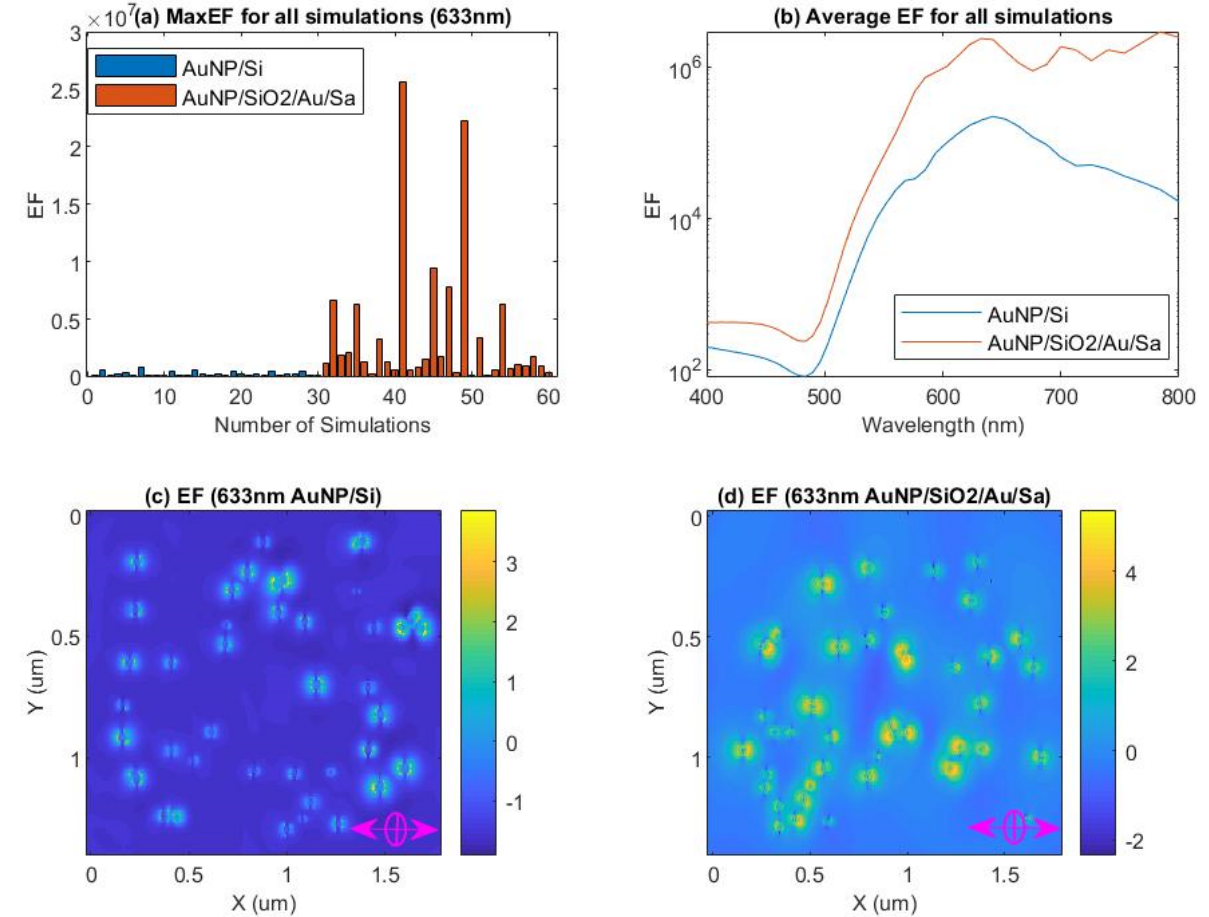
Figure 6. FDTD simulation of randomly distributed gold nanoparticles on silicon substrate (AuNP/Si) and randomly distributed gold nanoparticles on a silicon dioxide interception layer over a gold mirror on sapphire substrate (AuNP/SiO 2 /Au/Sapphire). ( a ) Maximum enhancement factor ( \ E \ / \ E 0 \ ) 4 at incident wavelength 633 nm for each run of model AuNP/Si and model AuNP/SiO 2 /Au/sapphire over an amount of 30 simulations, respectively. ( b ) Average value of the maximum enhancement factor ( \ E \ / \ E 0 \ ) 4 depends on the incident wavelength over an amount of 30 sim- ulations for model AuNP/Si and model AuNP/SiO 2 /Au/Sapphire, respectively. ( c ) Randomly selected enhancement factor ( \ E \ / \ E 0 \ ) 4 at the foot of randomly distributed gold nanoparticles on the surface of a silicon substrate (at XY plane) for model AuNP/Si with an incident wavelength of 633 nm. The color bar of the enhancement factor was in log scale (log{ ( \ E \ / \ E 0 \ ) 4 }). ( d ) Randomly selected enhancement factor ( \ E \ / \ E 0 \ ) 4 image at the foot of randomly distributed gold nanoparticles on the surface of the SiO 2 interception layer (at XY plane) for model AuNP/SiO 2 /Au/Sapphire with an incident wavelength of 633 nm. The color bar of the enhancement factor was in log scale (log{( \ E \ / \ E 0 \ ) 4